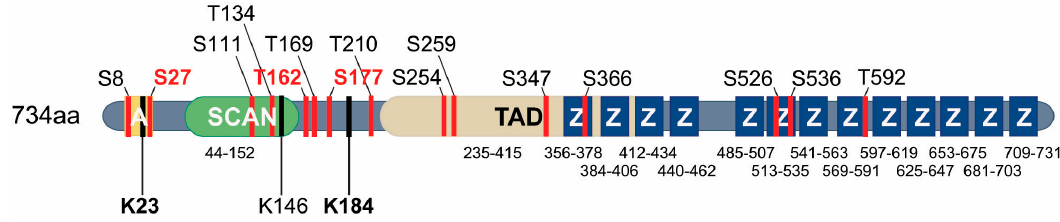
Figure 2. Schematic representation of the protein structure of full-length human MZF1 with reported SUMO-sites (K) and serine (S) and threonine (T) phosphorylation sites. The domain structure of MZF1 is presented as in Figure 1. The location of each indicated SUMO- and phospho-site is shown. The verified SUMO-sites are marked with bold font and the predicted SUMO-site (K146) is marked with regular font. The phospho-sites that are highlighted with red have been identified as ErbB2-responsive sites. Note that the serines 256, 274 and 294 corresponding to the ERK phosphorylation sites in the TAD of murine MZF1 have not yet been reported as phospho-sites in humans.